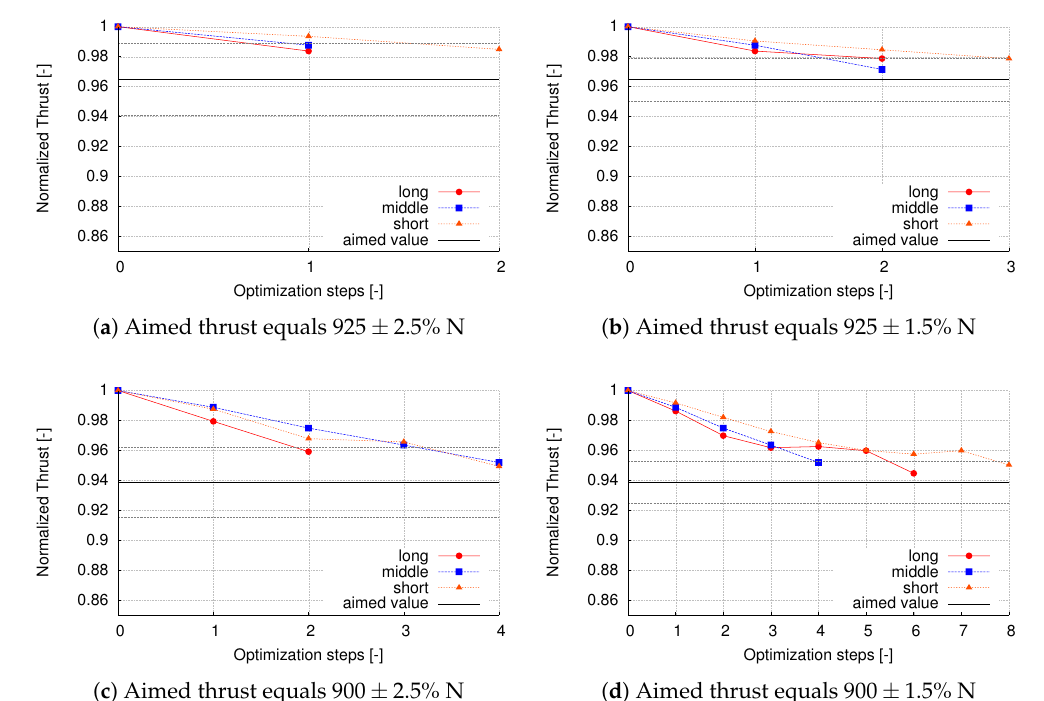
Figure 5. Development of the normalised thrust force over the optimization steps for design parameters within varying parts of the blade. Long: 2 m–4.5 m radial position, middle: 3 m–4.5 m radial position and short: 3.75 m–4.75 m radial position. The aimed values and the limits of the allowed range are shown with black and grey lines,